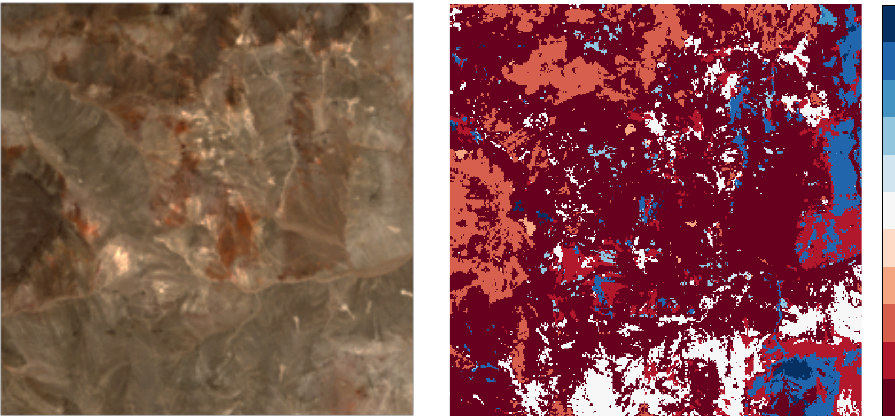
Figure 7. Left : The Cuprite ROI. Right : The class map.